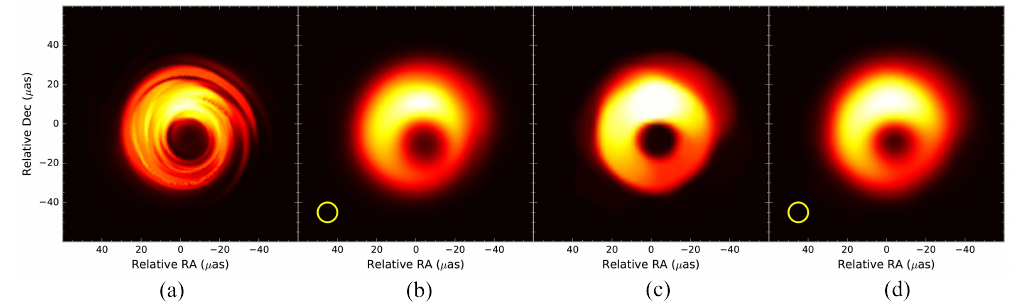
Figure 3. Bi-Spectrum Sparse Modeling (BSSpM) reconstruction of a disk-jet model of M87 at 1.3 mm. ( a ) The original model [48]; ( b ) The model convolved with a 10 µ as Gaussian; ( c ) The BSSpM reconstruction of the image from simulated data [47]. The fringe spacing of the longest baseline is approximately 25 µ as; ( d ) The BSSpM reconstruction convolved with a 10 µ as Gaussian. BSSpM successfully recovers features of the model at a superresolution of 40% of the fringe spacing. A linear transfer function is used in all